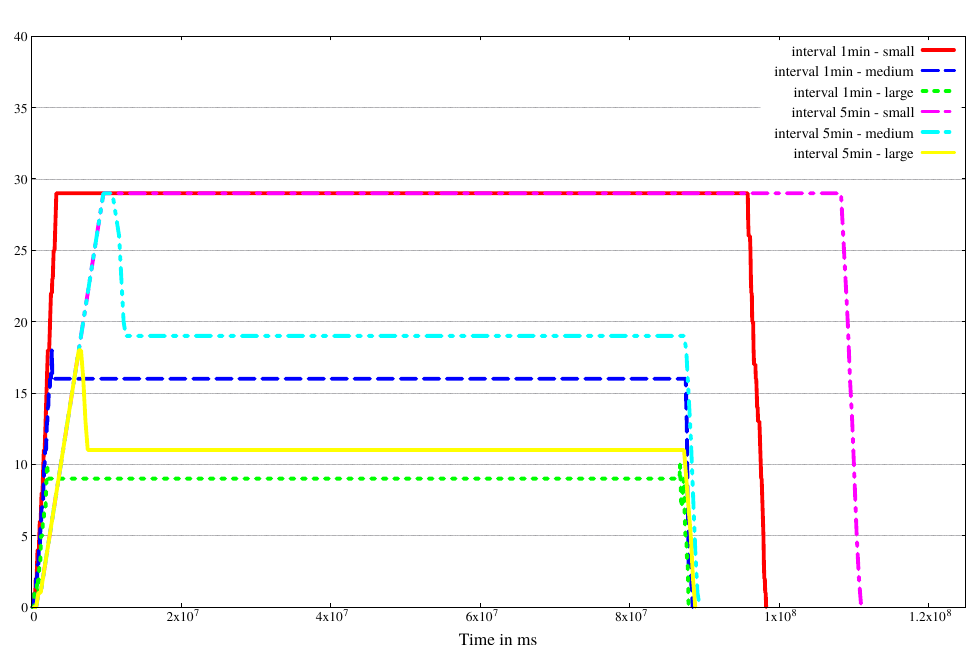
Figure 14. Cost of the IoT providers in N o 4.